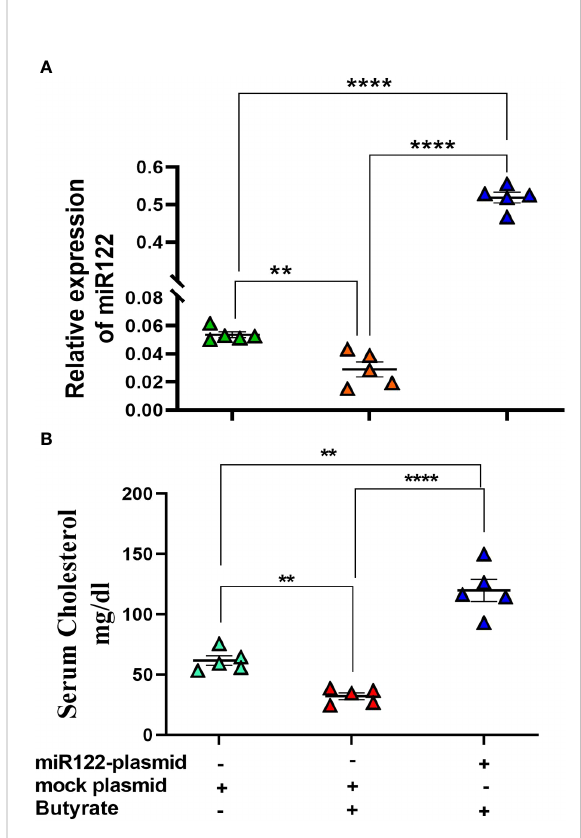
FIGURE 7 miR122 overexpression in liver rescues butyrate-induced decrease in serum cholesterol. Each butyrate-treated female mice were injected with either 25 µg in 100 µl of miR122 expressing plasmid or 25 µg in 100 µl of mock plasmid in tail vein. The mice were sacri fi ced 4 days post-injection. The serum cholesterol and hepatic miR122 expression was measured. N = 5; the data are presented as mean ± SE. The experiment was repeated twice. **** represents p < 0.0001 and ** represents p <